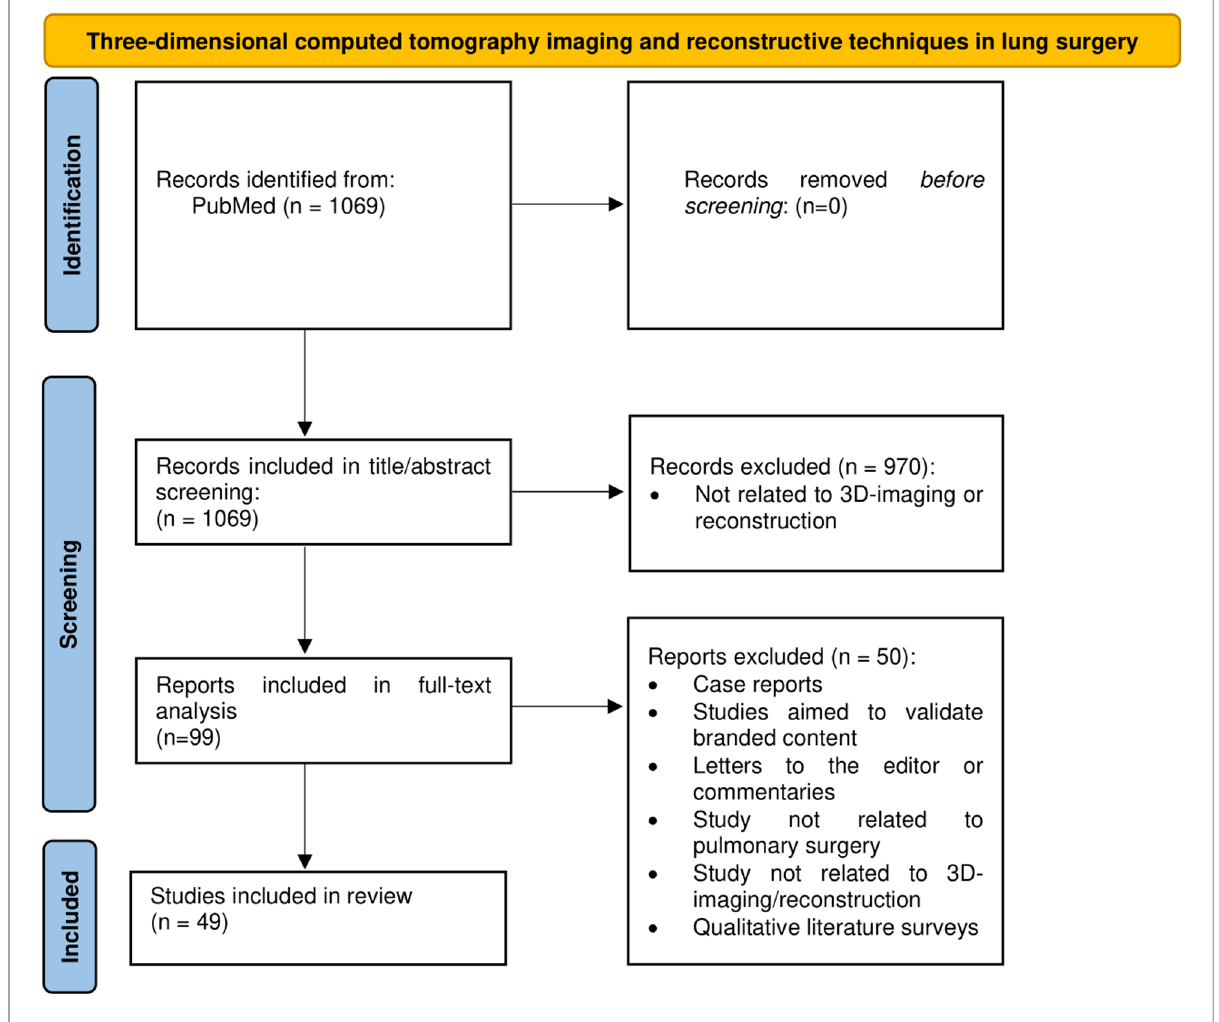
FIGURE 1 Flowchart of the conducted search. 3D: